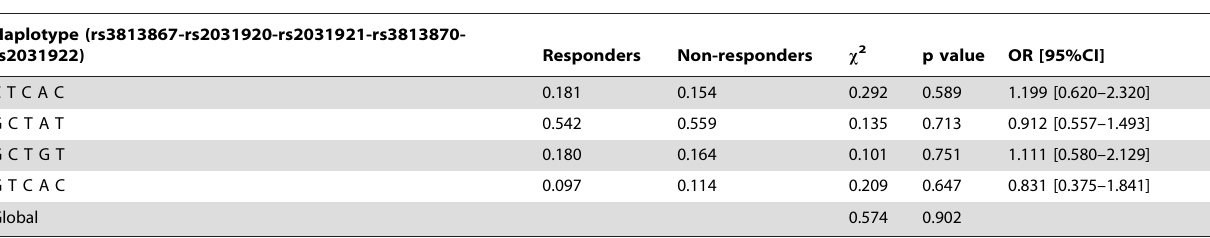
Table 6. Frequencies of estimated haplotypes and test statistics between responders and